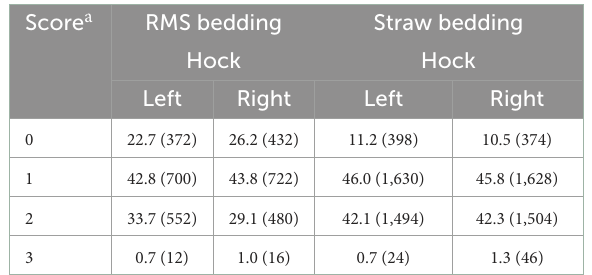
TABLE 6 Percentage (number) of cow’s hock lesion scores by bedding type on 27 recycled manure solids bedded farms and 61 straw-bedded